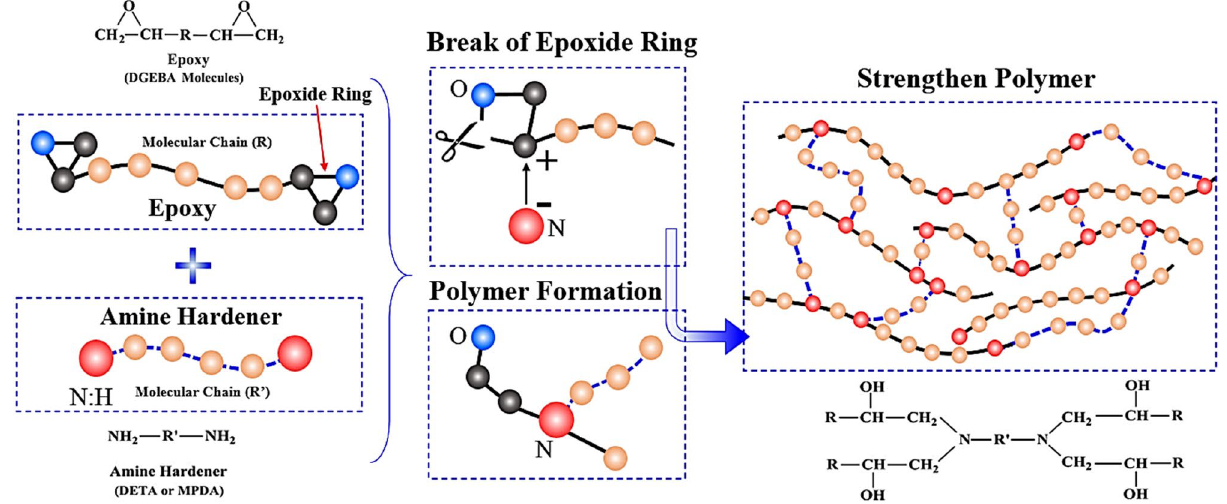
Figure 10. Schematic representation of reactants and formation of crosslinks in epoxy